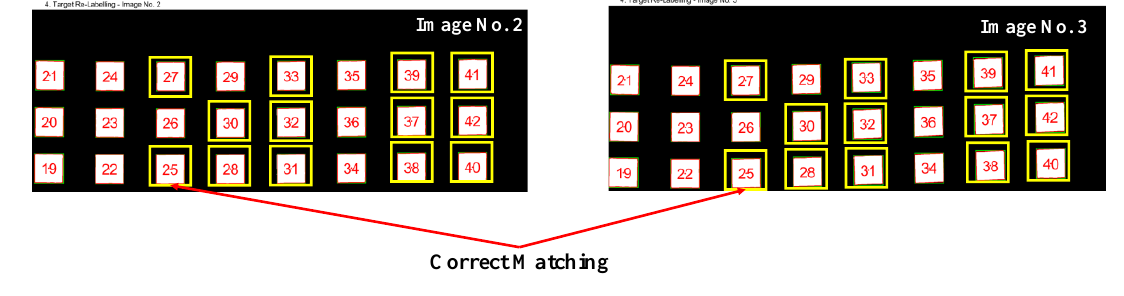
Figure 7. Correction of TP label mismatching.